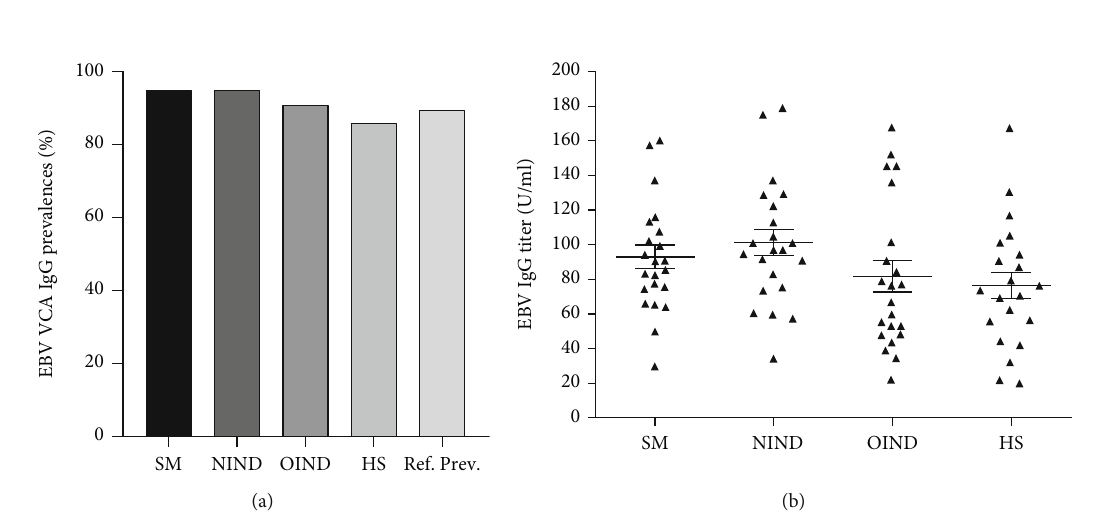
Figure 4: EBV seroprevalence and titer in sera from MS and other neurological diseases a ff ected patients. (a) Prevalence of immunoglobulin G (IgG) antibodies reacting to EBV-VCA in MS and other neurological diseases a ff ected patients from our data and prevalence, as reported by Wong and colleagues [28]. (b) The titer values of EBV-VCA are shown as scatter dot plot, where IgG mean values and their standard error mean (SEM) are marked by short horizontal lines. The VCA-EBV IgG levels were not statistically di ff erent among the cohorts ( p > 0 : 05